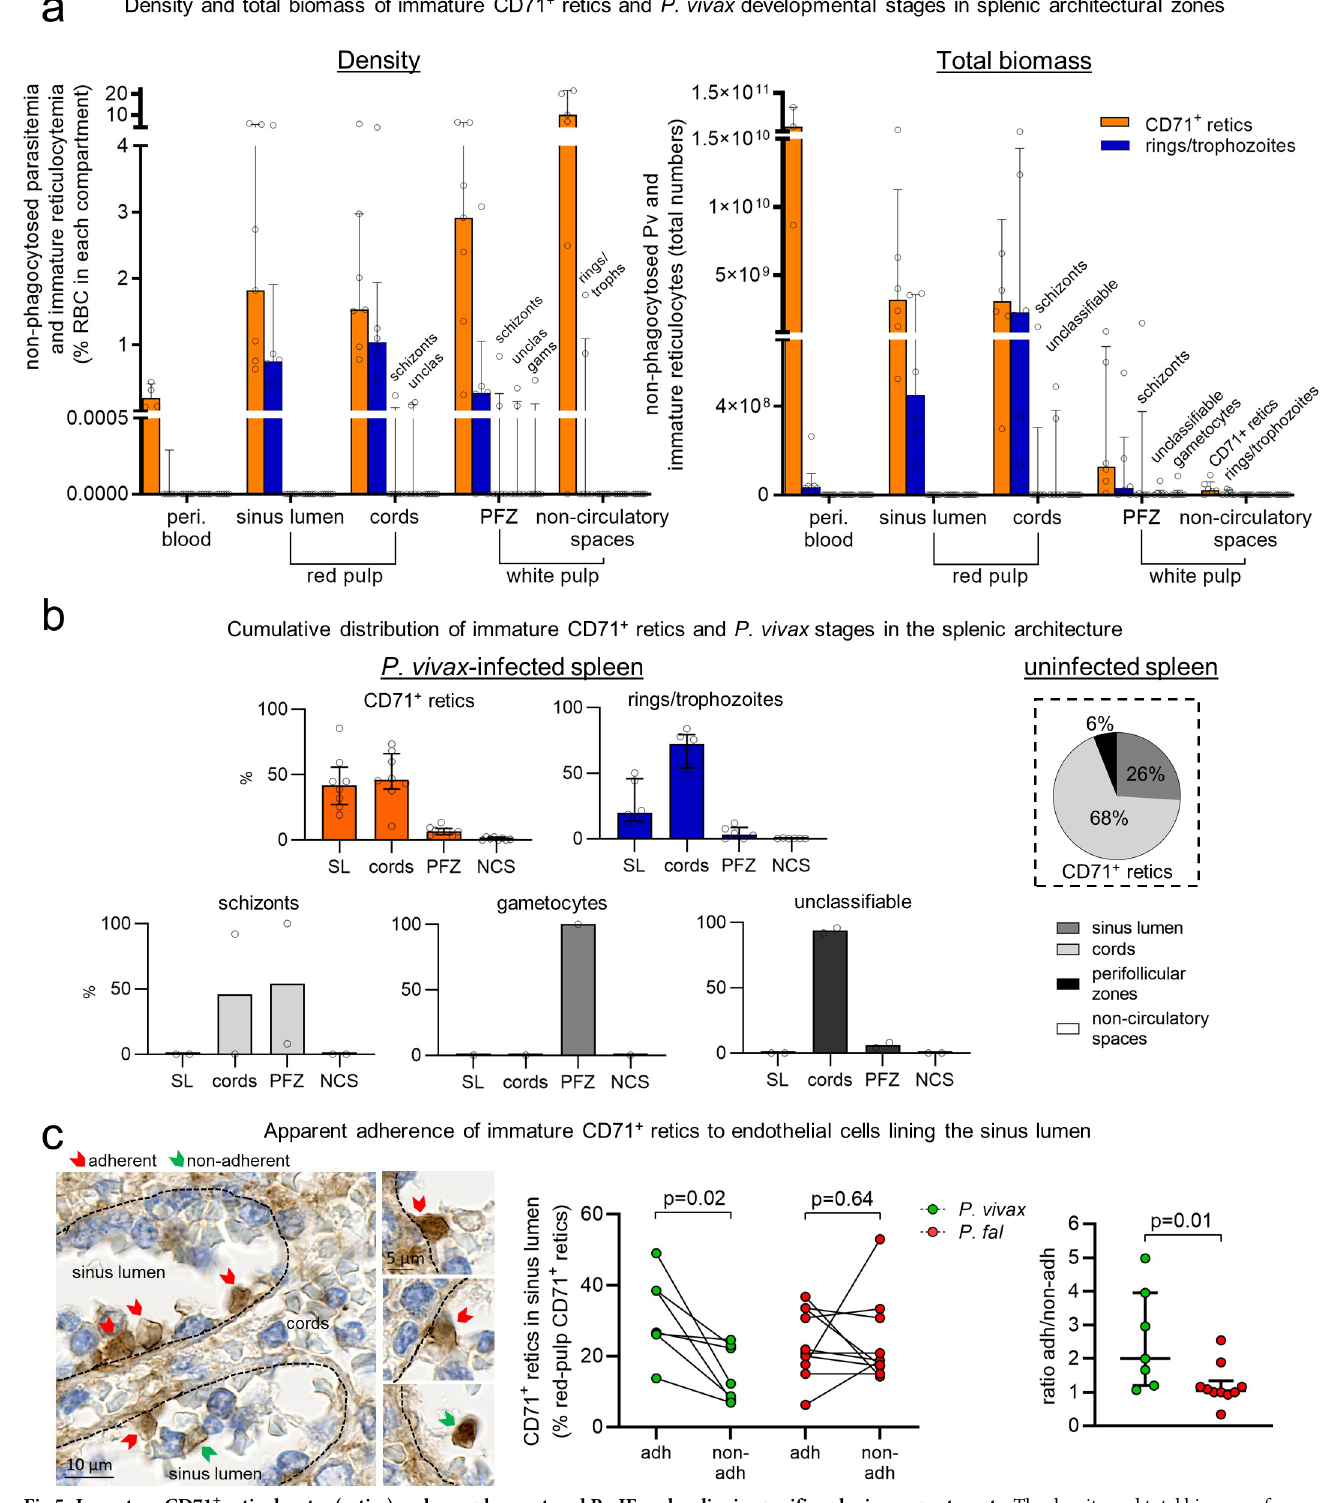
Fig 5. Immature CD71 + reticulocytes (retics) and non-phagocytosed Pv-IEs colocalise in specific splenic compartments. The density and total biomass of CD71 + retics and non-phagocytosed Pv developmental stages ( n = 6) were determined in the red-pulp SL, cords, PFZ, and white-pulp NCS (a). Non-phagocytosed Pv parasites were categorised into 3 groups (rings/trophozoites, schizonts, gametocytes), and a fourth group of those with unclassifiable stages. The cumulative